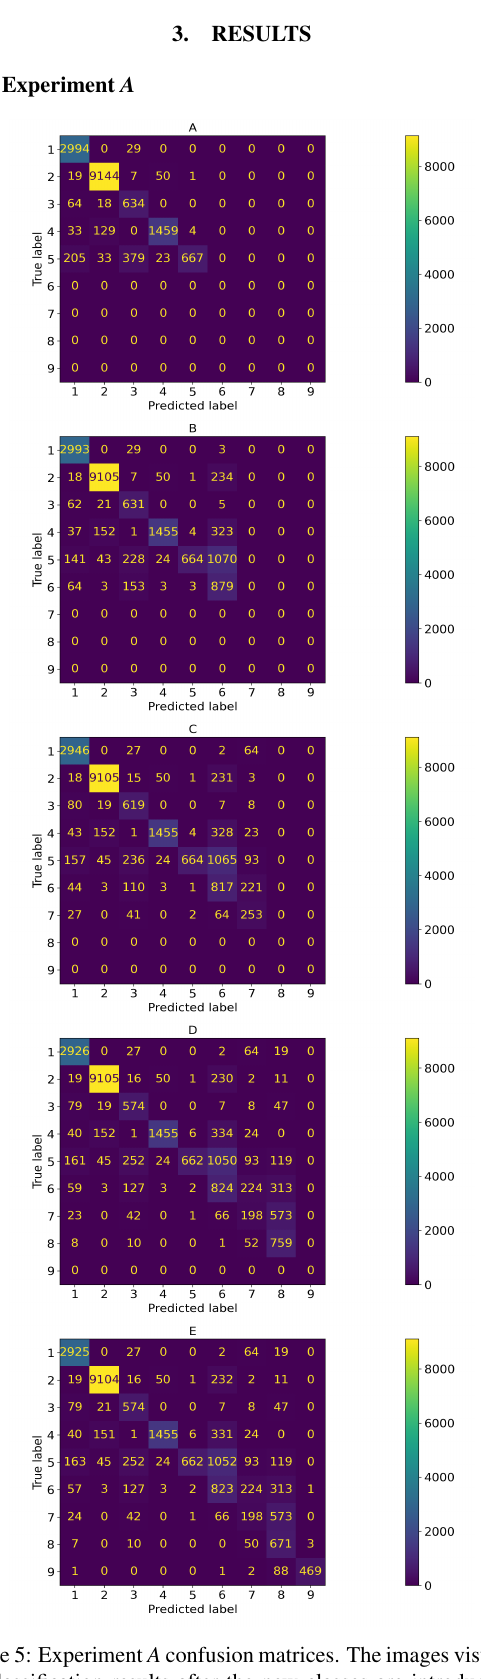
Figure 5: Experiment A confusion matrices. The images visualise the classification results after the new classes are introduced to the self-learning MLM. Image A new class: 5, B new class: 6,